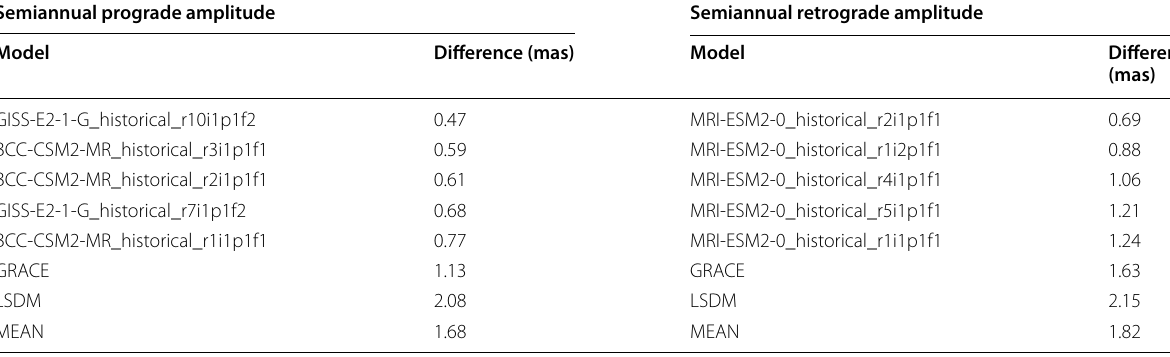
The results obtained from GRACE, LSDM, and MEAN model are also shown Table 5 Absolute values of differences in phase of semiannual prograde and semiannual retrograde oscillation between GAO and HAM from CMIP6 (only the five models with the smallest differences are shown) Semiannual prograde